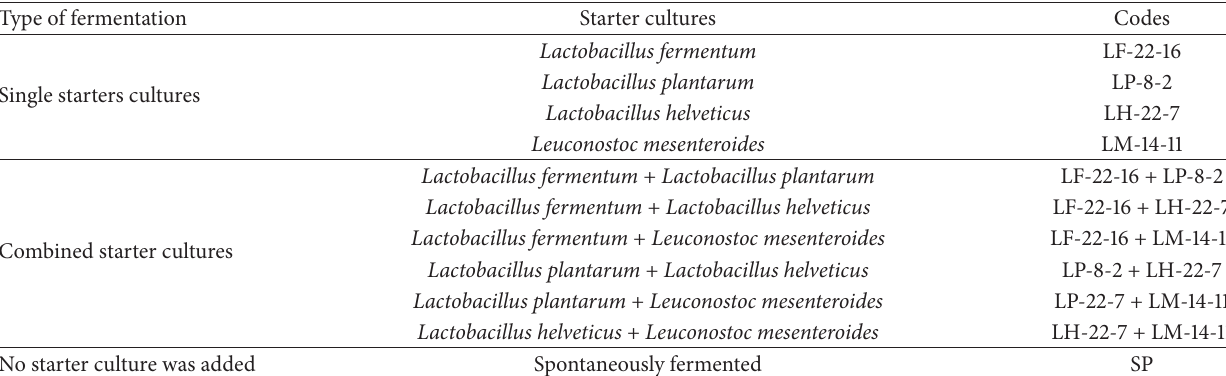
Table 1: Starter cultures used for Nunu